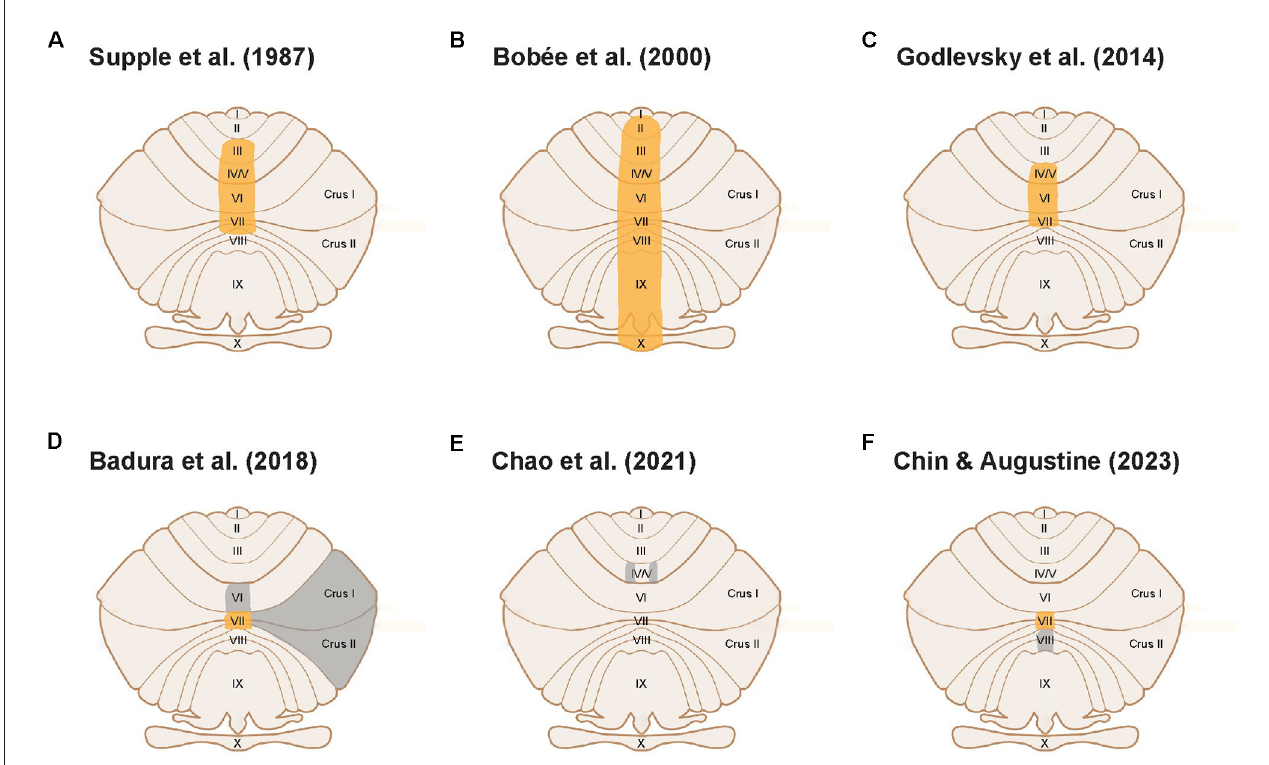
FIGURE1 Cerebellar cortical areas experimentally tested for a functional role in anxiety behavior. Unfolded view of the cerebellar cortex illustrates cerebellar lobules. Orange areas indicate cerebellar lobules implicated in anxiety behavior; gray areas indicate cerebellar areas that were not implicated in anxiety behavior. (A–C) Large-scale lesion or electrical stimulation studies establishing a cerebellar role in anxiety. (D) Lobule VII modulates anxiety behavior, whereas lobules VI, Crus I, and II do not. (E) Areas within lobules IV/V do not affect anxiety behavior. (F) Lobule VII modulates anxiety while lobule VIII does